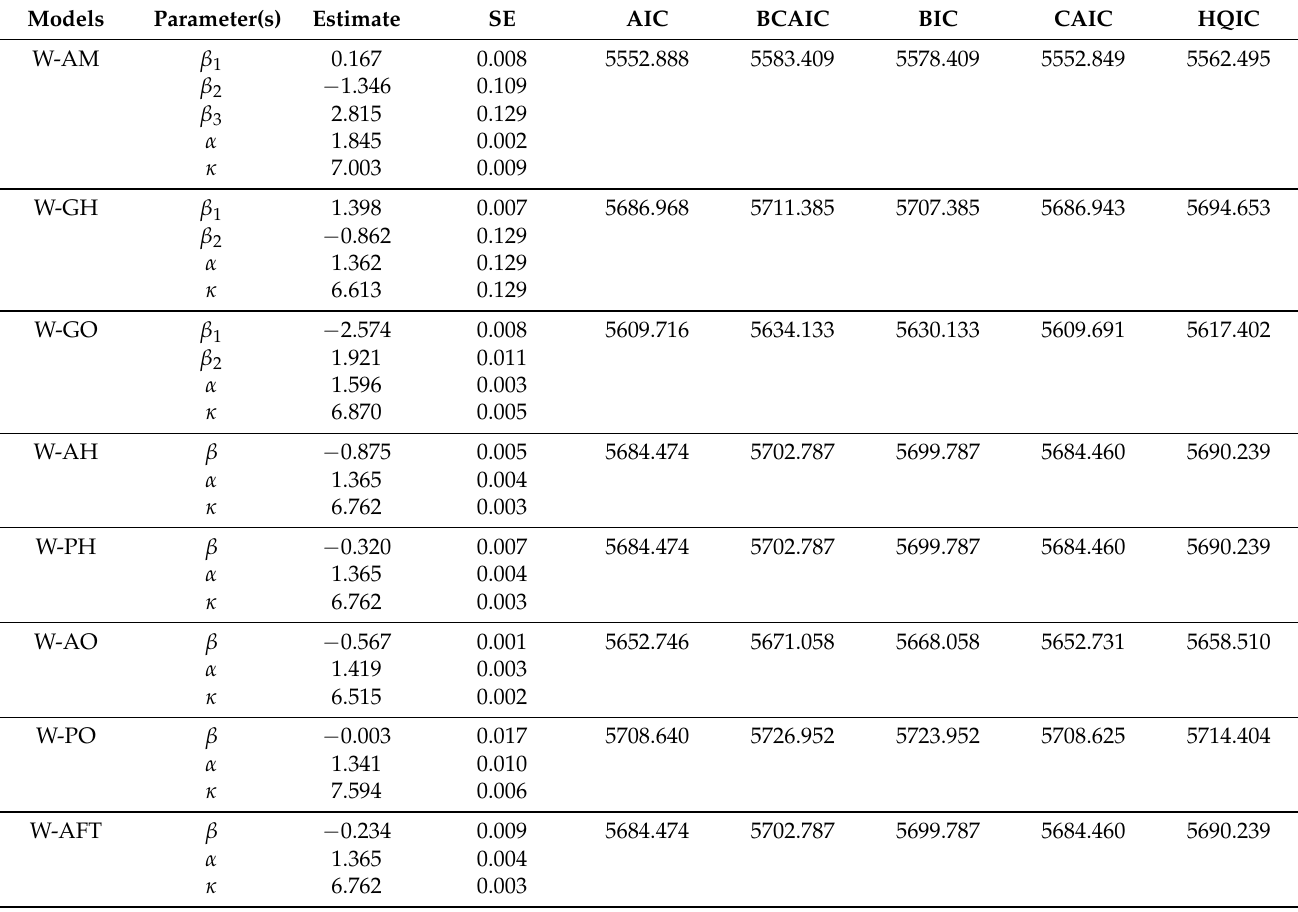
Table 2. Results from the fitted proposed fully-parametric odds-based and hazard-based regression models with W baseline distribution to IPASS dataset.